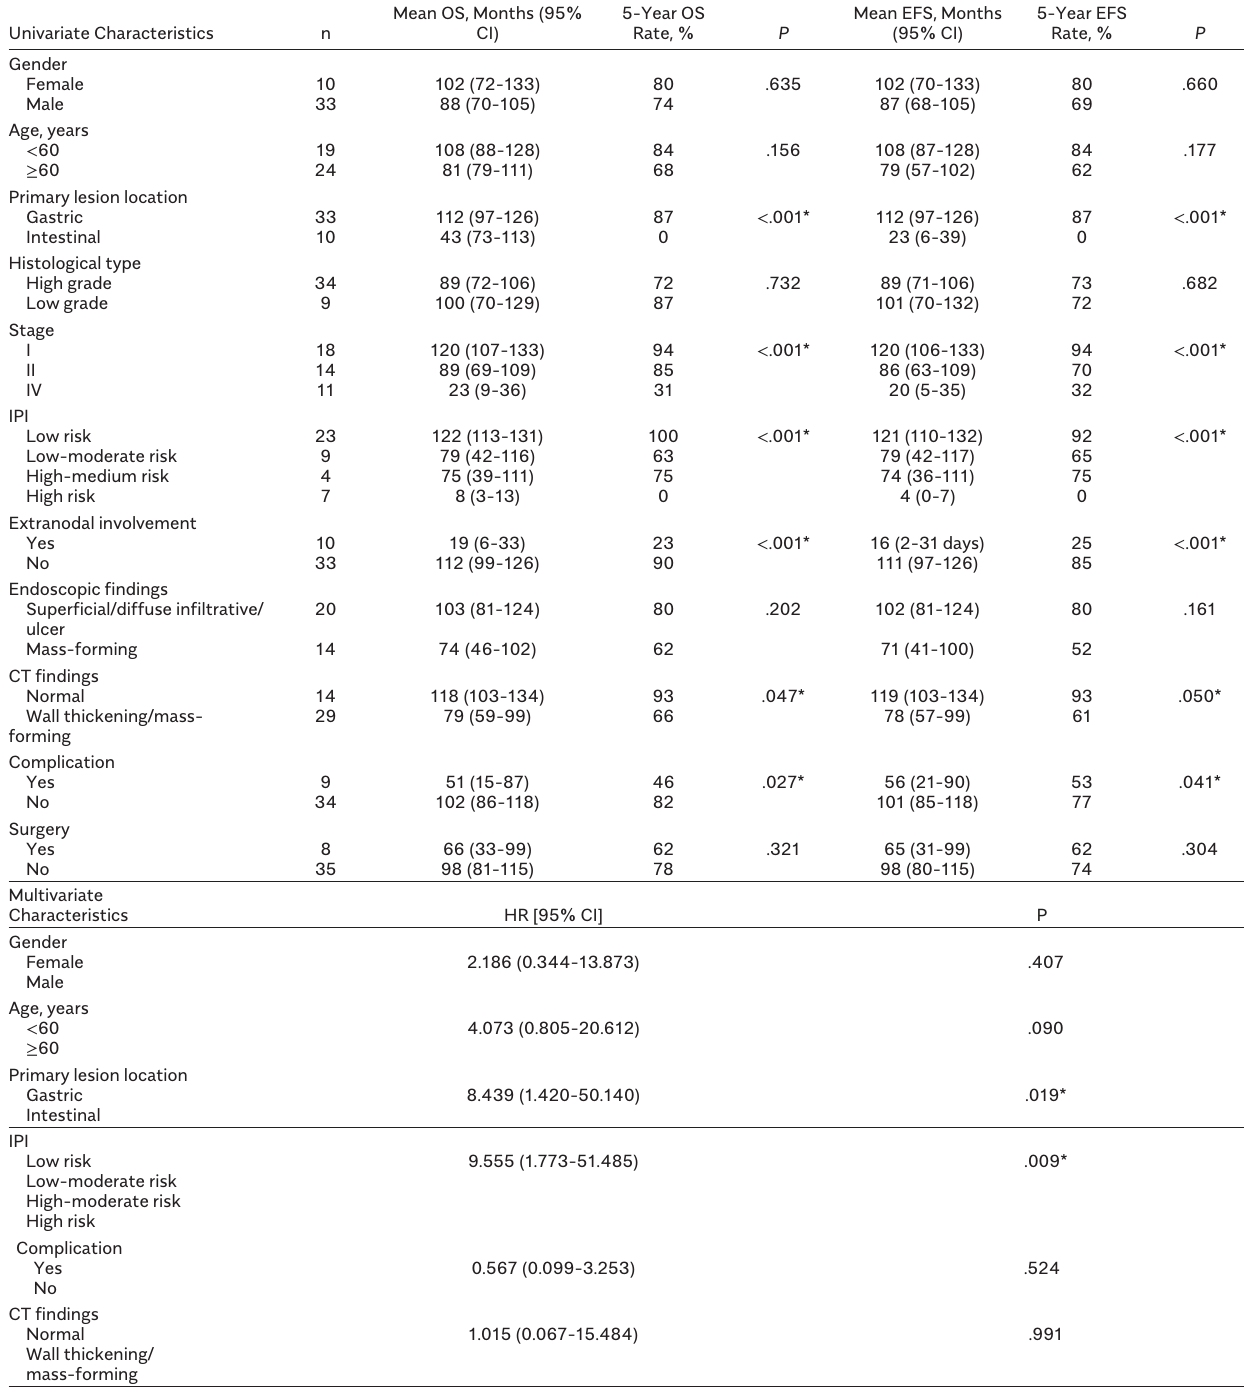
Table 4. Univariate and Multivariate Analysis of Patients with Primary Gastrointestinal Lymphoma